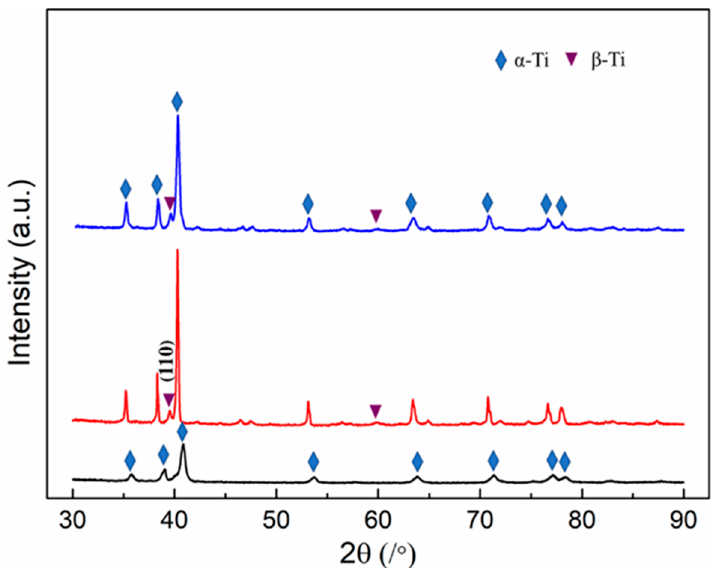
Figure 3. Comparison of XRD Plots for the various St at Ht of 180 min and Hr of 7.5 °C/min.